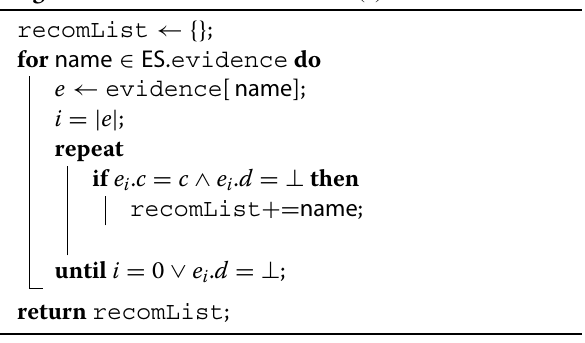
Algorithm 12: MCELSA . detRecom ( c )